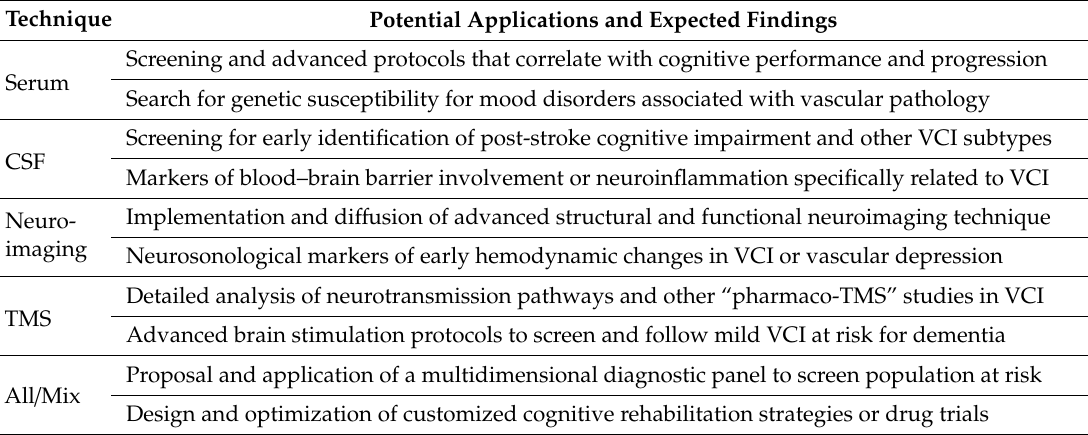
Table 2. Research agenda and future avenues of translational research in VCI